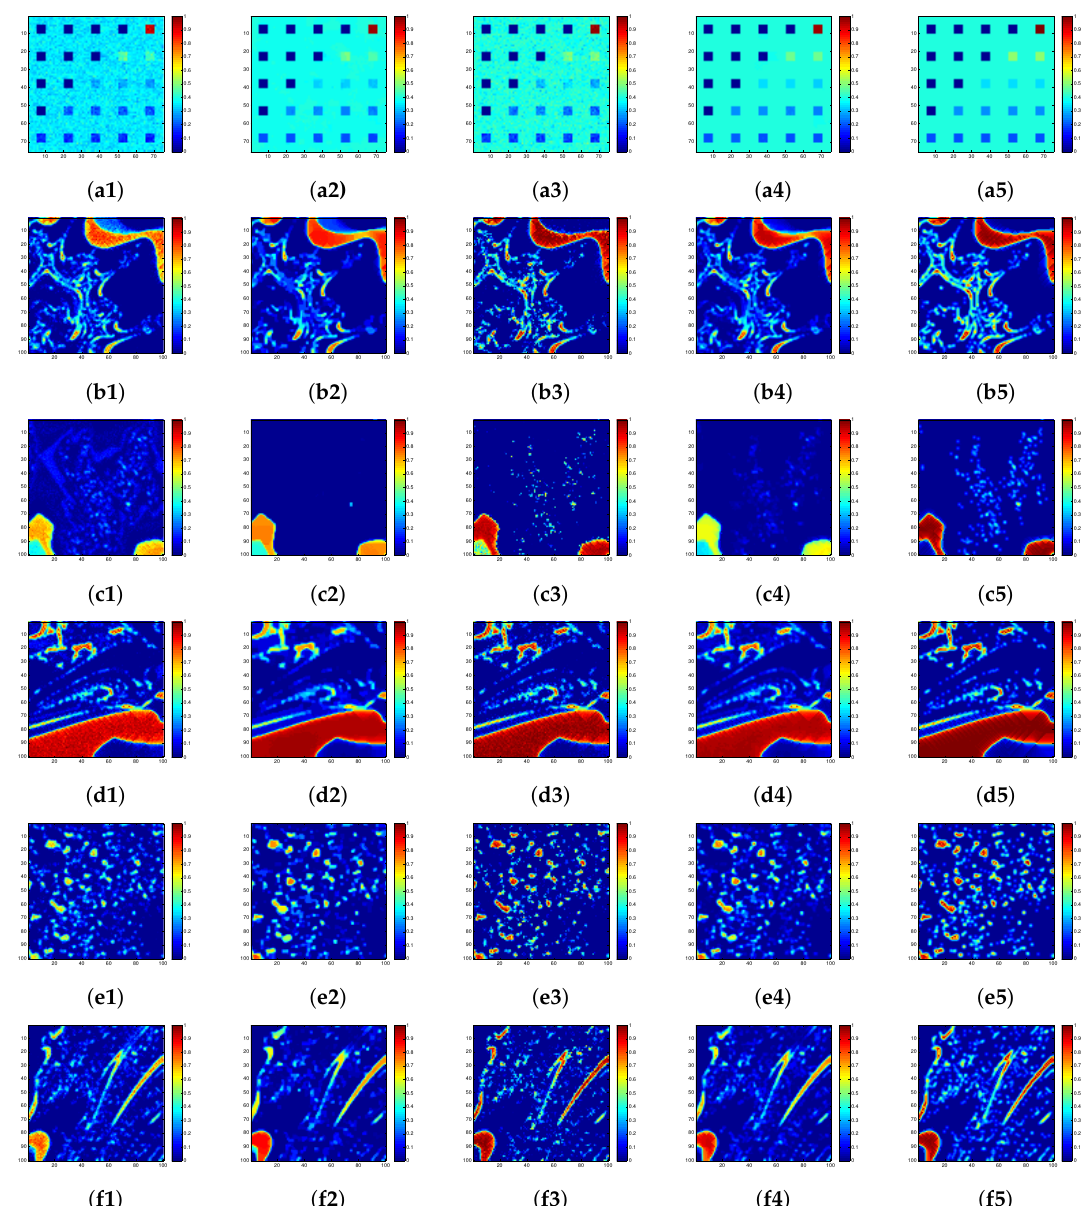
Figure 8. Estimated abundance maps for simulated data sets DS and FR1–5 for SNR 30 dB (row a – f , respectively) using CLSUnSAL, SUnSAL-TV, ADSpLRU, and J-LASU (column 1–4 , respectively) compared to the true abundance (column 5